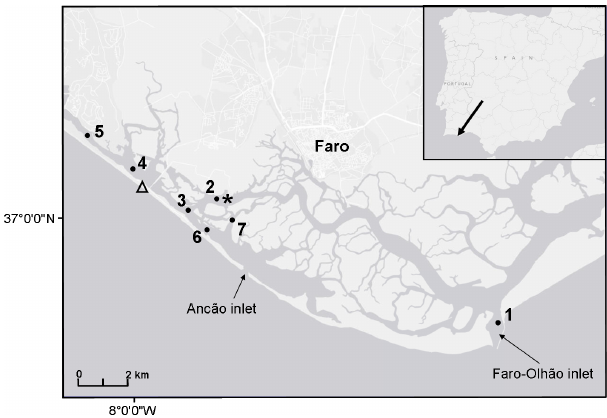
Figure 1. Map of the lagoon Ria Formosa, Portugal. Asterisk: site of seagrass meadow studies; triangle: sampling site on the Praia de Faro (upwind position). Dots with numbers represent sampling points during the transect